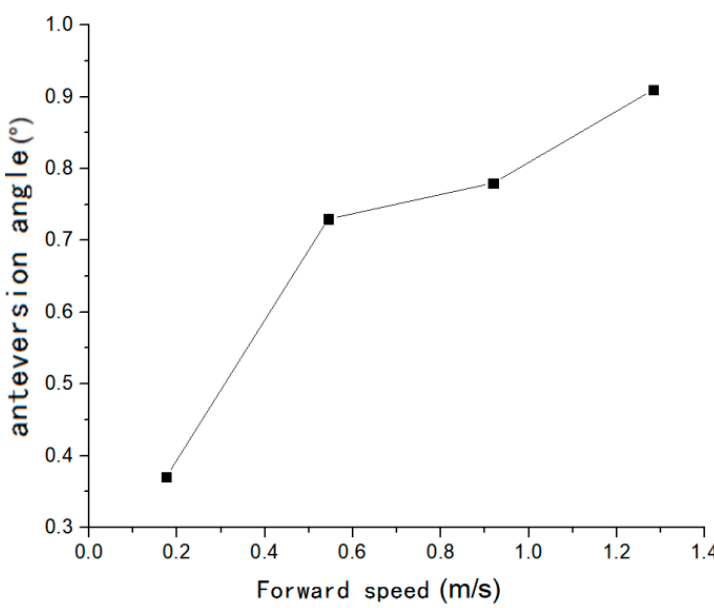
Figure 20. Relationship between forward tilt angle and forward speed.